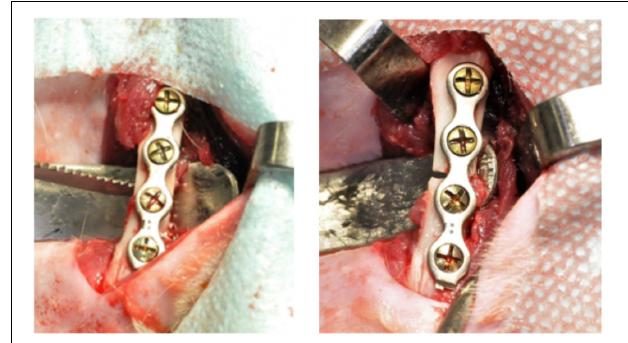
FIGURE 1 | 4-hole titanium plate of 2.0 mm system with four screws of 2.0 mm and fracture performed using a reciprocating